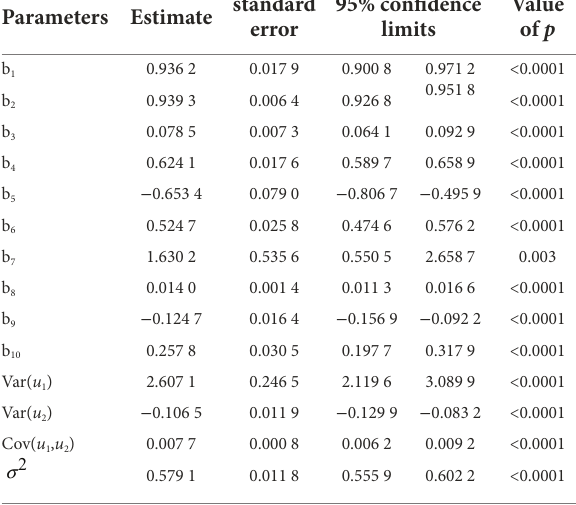
TABLE 7 Parameter estimates and variance components for the best combinations b 6 and b 8 of the nonlinear mixed effect model. standard Parameters Estimate error